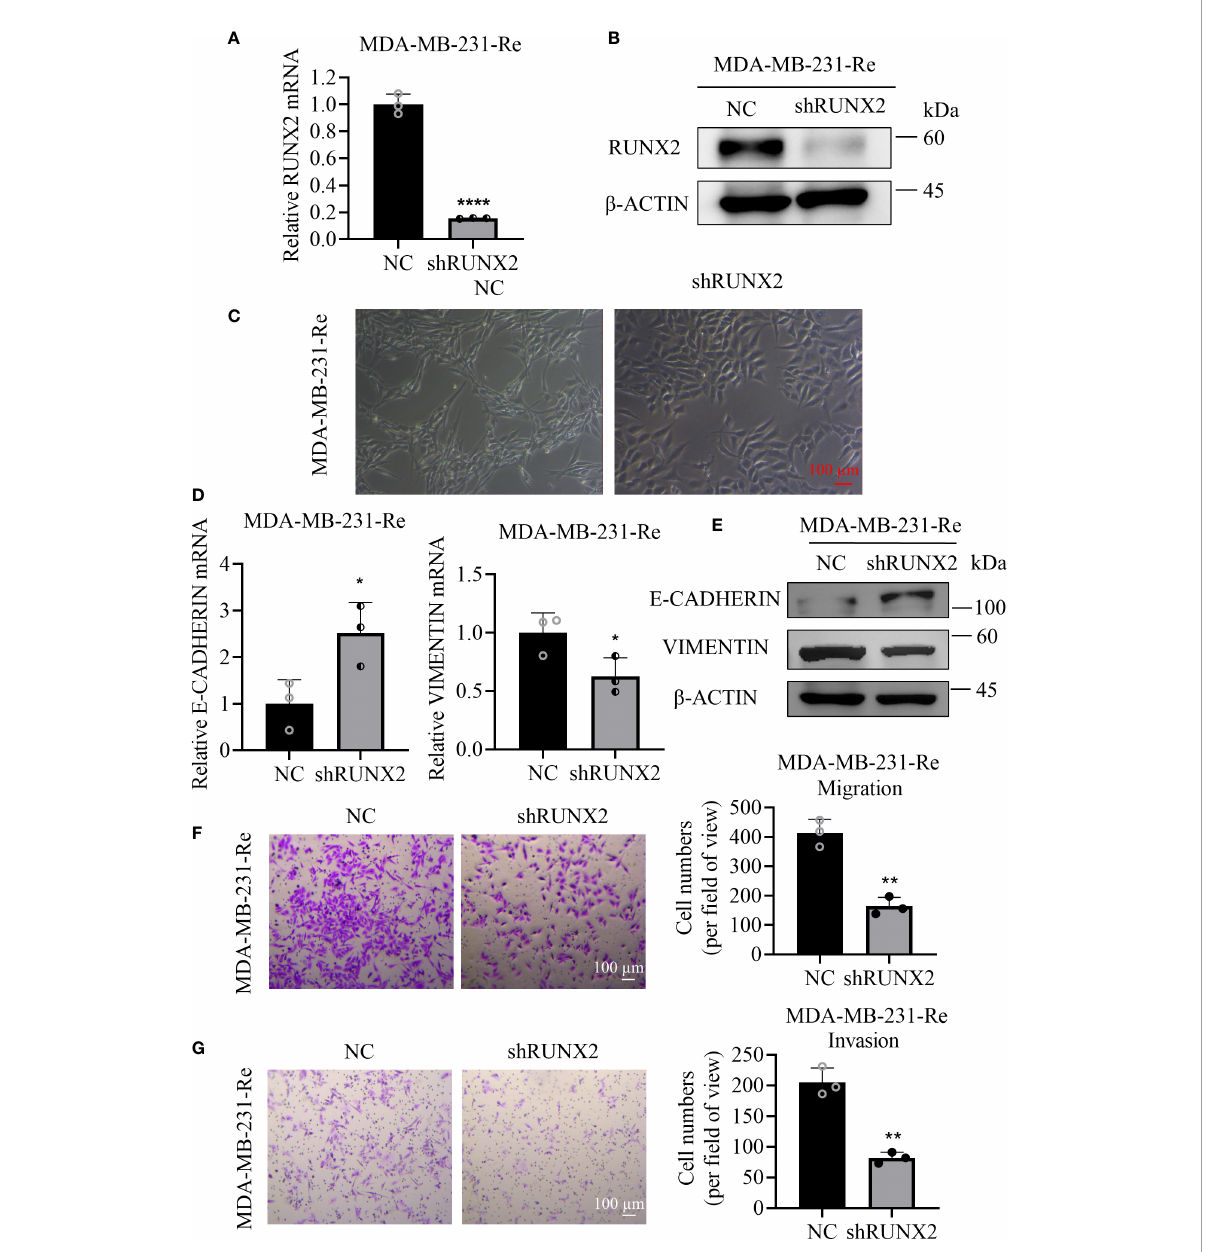
FIGURE 2 In fl uenceof shRUNX2 onthemigrationandinvasionof drug-resistantcellsintriplenegativebreastcancer. (A) qRT-PCRanalysisof RUNX2 expressionin MDA-MB-231-RecellswithstableRUNX2knockdown(shRUNX2)orScramble-transducednegative control (NC). (B) Protein levelsof RUNX2 and b -ACTIN were determinedby western-blottingassay. (C) CytomorphologyoftheshRUNX2 andNCMDA-MB-231-Recellswasobservedunderthemicroscope. Scale bar=100 µm. (D) qRT-PCRassay foranalyzingtheexpressionof E-CADHERINandVIMENTINin theshRUNX2 andNCMDA-MB-231-Recells. (E) proteinlevelsofE-CADHERIN, VIMENTINand b -ACTINweredeterminedbywestern-blottingassay. (F) Themigrationability of theshRUNX2andNC MDA-MB-231-Recellsassessedby Transwell assay.Scalebar=100um. (G) Theinvasionabilityofthe shRUNX2 andNCMDA-MB-231-Recellsassessedby Transwellassay. Scalebar=100µm. All datawereshownasmean±SD(N=3independentexperiments). *P